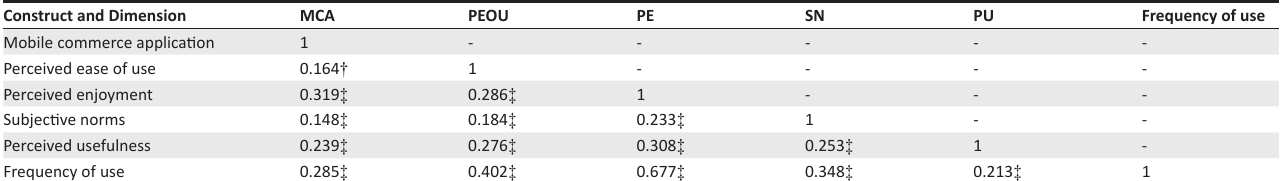
TABLE 3: Mobile-commerce acceptance: Inter-dimensional correlation analysis. Construct and Dimension